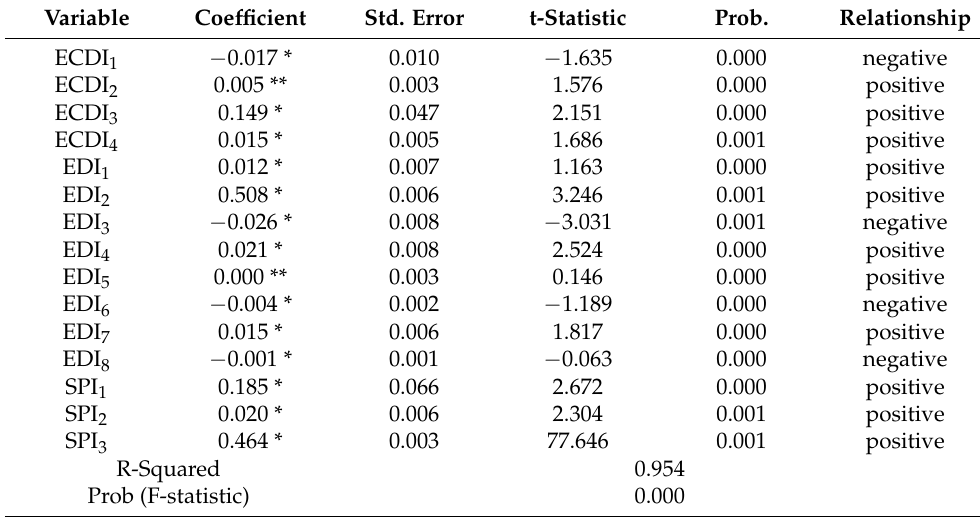
Table 4. Panel regression results for the fixed-effects model.